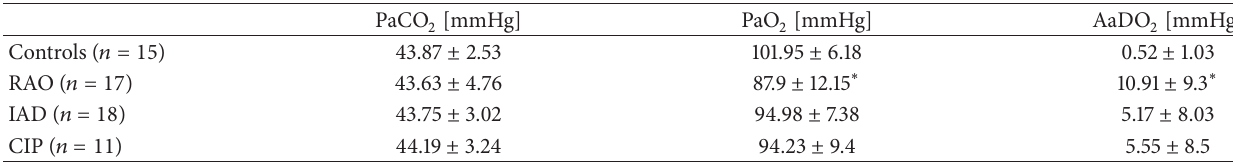
Table 4: For arterial blood gas analysis, the results are expressed as mean ± SD. ∗ shows significant difference to controls at 𝑝 < 0.05 . RAO: recurrent airway obstruction, IAD: inflammatory airway disease, and CIP: chronic interstitial pneumopathy.